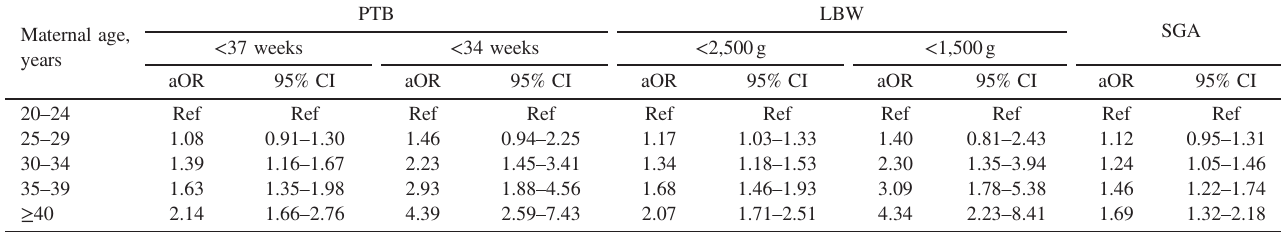
Table 2. Relation between maternal age and preterm birth, low birth weight, and small for gestational age PTB Maternal age, years